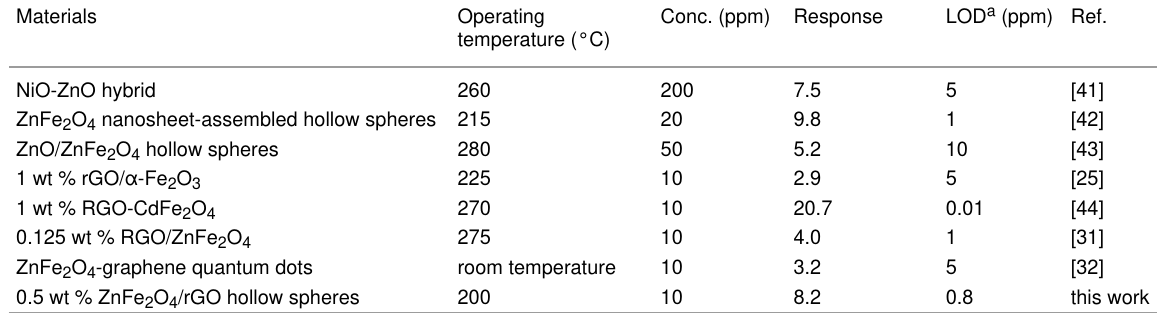
Table 1: Comparison of the acetone sensing performance of various reported sensors based on different